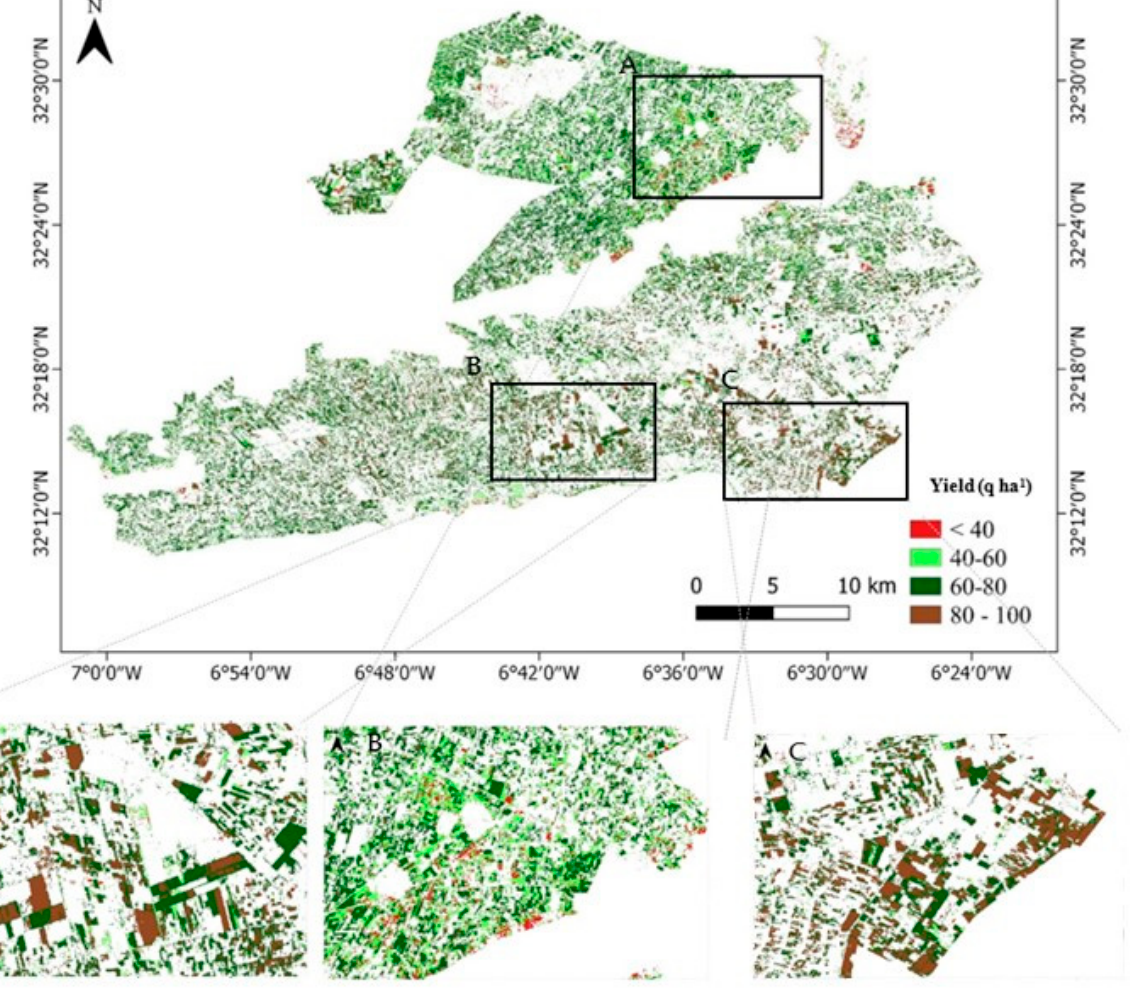
Figure 8. Wheat yield map (q ha − 1 ) of TIP region based on model 5, for the 2020/2021 agricultural